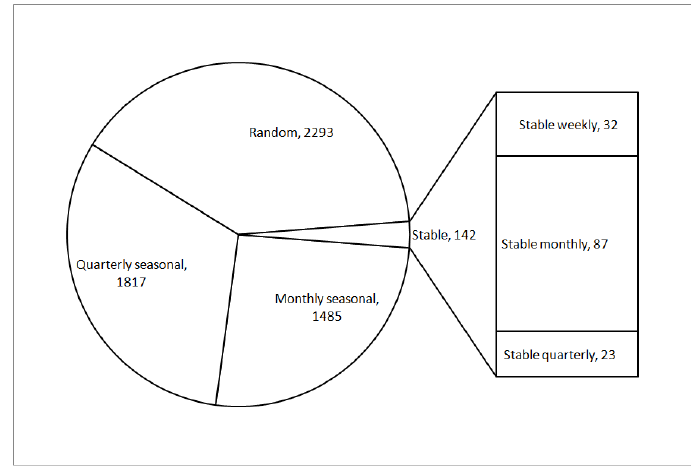
Figure 3. Product distribution in 2005.